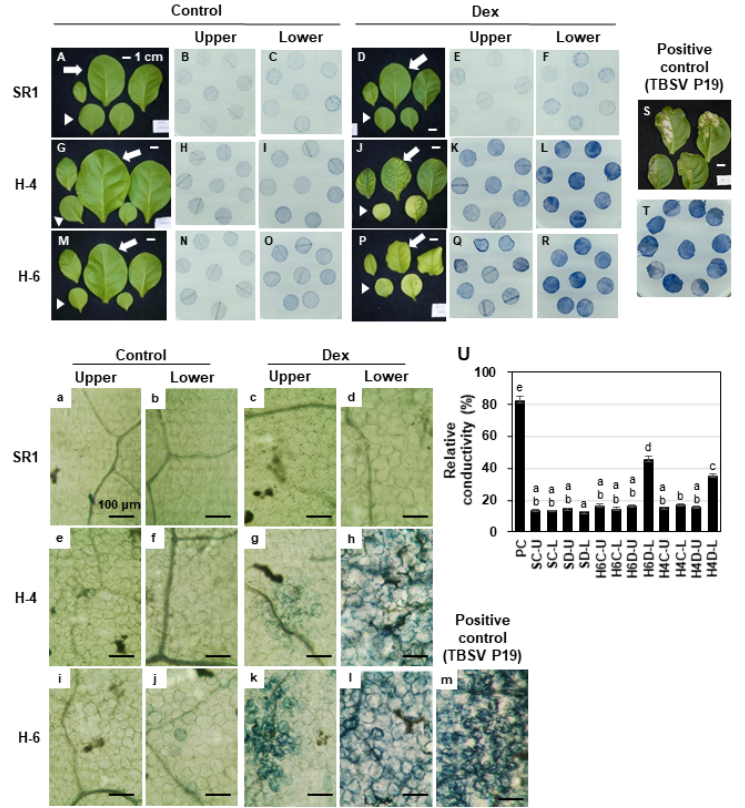
Figure 5. Detection of cell death in chlorotic leaves. Control plants (SR1; A – F and a – d ) and i-hpHSP90C transgenic line 4 (H-4; G – L and e – h ) and line 6 (H-6; M – R and i – l ) plants were grown and treated with control or Dex solution. They were harvested and photographed at 7-dpt ( A , D , G , J , M , P , S ; representative plants from triplicate experiments; scale bars denote 1 cm) followed by cell death assays. SR1 leaves transiently expressing TBSV P19 for 2 days served as a positive control ( S , T , m ). Cell death assay was performed in upper leaves (indicated by arrows) and lower leaves (indicated by arrowheads) Leaf disks of 6 mm in diameter were stained with trypan blue and photographed at macroscopic ( B , C , E , F , H , I , K , L , N , O , Q , R , T ) and microscopic ( a – m ; scale bars denote 100 µm) levels. ( U ), quantification of cell death by an electrolyte leakage assay; PC, positive control with transient TBSV P19 expression; SC, control-treated SR1; SD, Dex-treated SR1; H4C, control-treated line 4; H4D, Dex-treated line 4; H6C, control-treated line 6; H6D, Dex-treated line 6; U, upper leaves; L, lower leaves. Error bars denote standard deviations in triplicate experiments. Di ff erent letters indicate statistically significant di ff erences between treatments (LSD test, p < 0.05). The experiment was repeated at least three